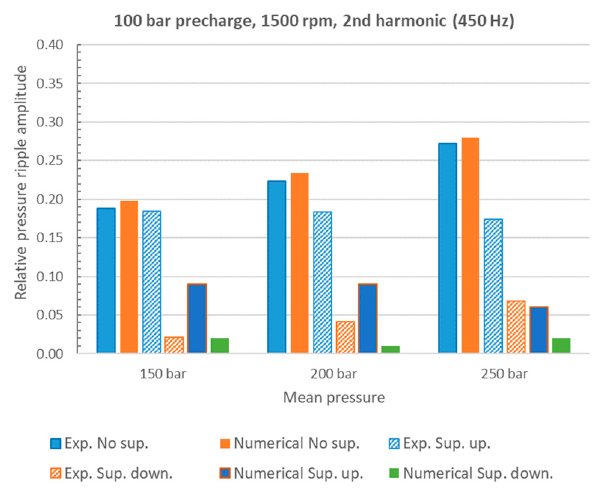
Figure 16. FFT of the pressure ripple, 2nd harmonic, pump speed = 1500 rpm.